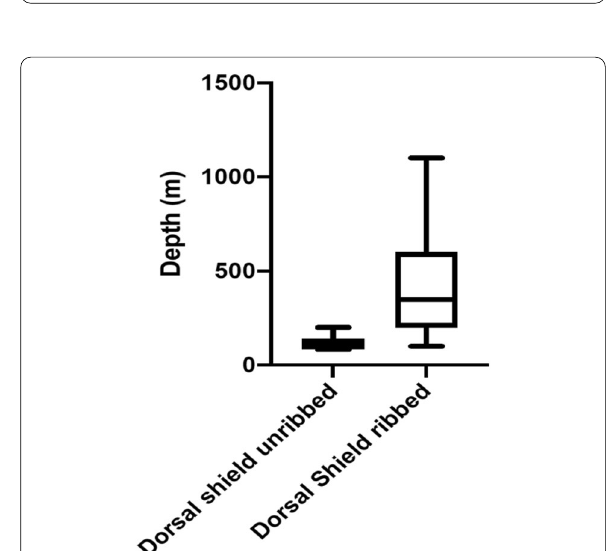
Fig. 13 Mean maximum depths of cuttlebones with and without dorsal shields with strengthening